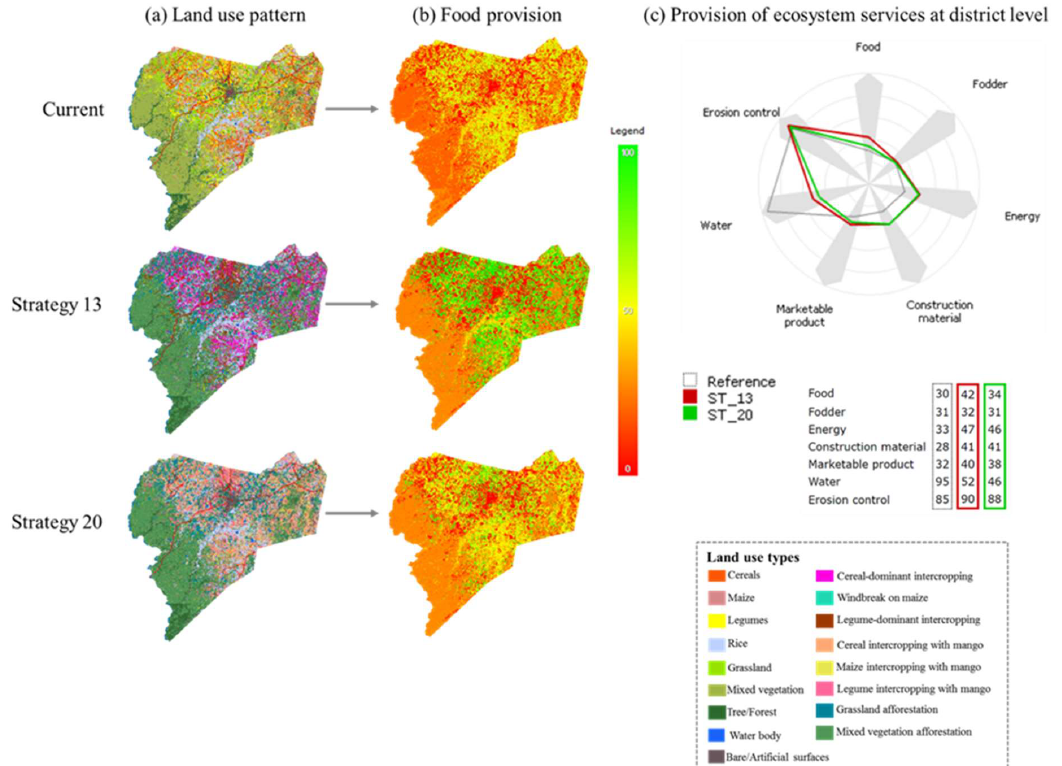
Figure 5. Potential impacts of land-use strategies on the land-use patterns and the provision of ecosystem services in Bolgatanga. The application of strategy 13 (ST_13) and strategy 20 (ST_20) results in rearranged land-use patterns ( a ). Provisioning maps for ecosystem services (e.g., food provision) show the impacts of the rearranged land-use patterns on the spatial distribution of ecosystem services ( b ). The spider chart and the ecosystem services balance table show changes in the provision of ecosystem services compared to the current provision of ecosystem services as reference ( c ). When these two strategies are compared, strategy 13 is more effective to enhance ecosystem services. The images were captured from GISCAME.